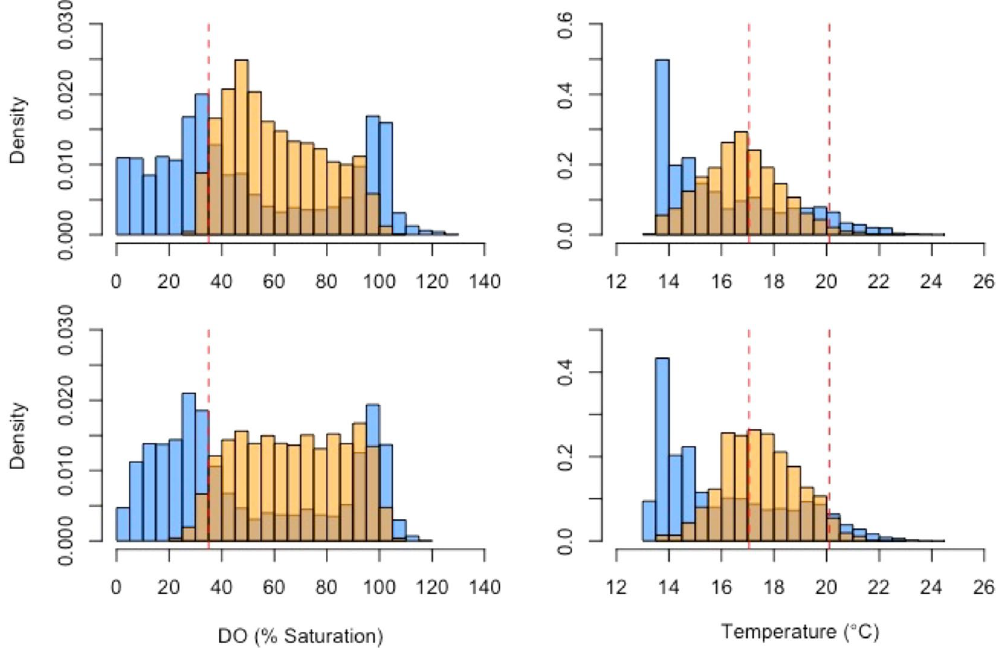
Figure 1. Distribution of DO and temperature values experienced by the fish and measured inside the cages. Values measured by fish are displayed in orange, those measured throughout the cage water column in blue. Data from cage 1 is shown in the top panel, data from cage 2 is shown in the bottom panel. Vertical dashed lines indicate the 35% DO saturation threshold in the DO distributions and the mean and 97.5 centile in the temperature distributions. To account for the fact that some stationary string tags malfunctioned during parts of the study period, water column data were grouped into 2.5 m depth bins and each data point weighted by the inverse of the total number of observations for its depth bin for the computation of density